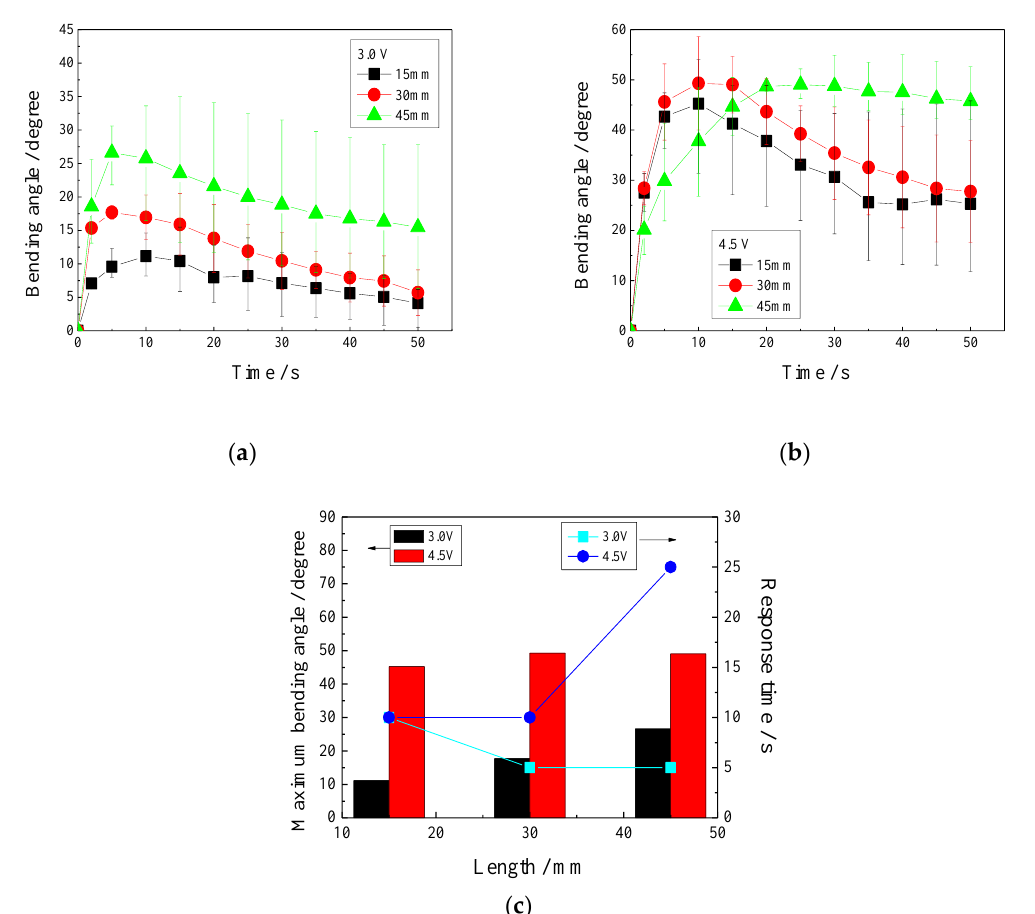
Figure 8. Bending angles of the IPMCs with various lengths under different voltages. ( a ) 3.0 V; ( b ) 4.5 V; ( c ) relationships between the maximum bending angles or the response time and the lengths.